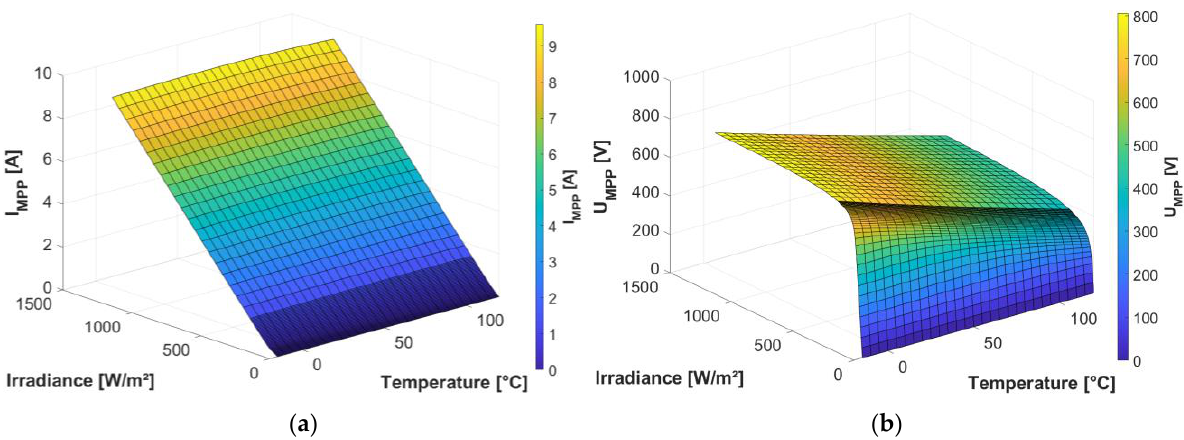
Figure 3. Characteristic diagram of I MPP f(T,G) ( a ) and characteristic diagram of U MPP f(T,G) ( b )